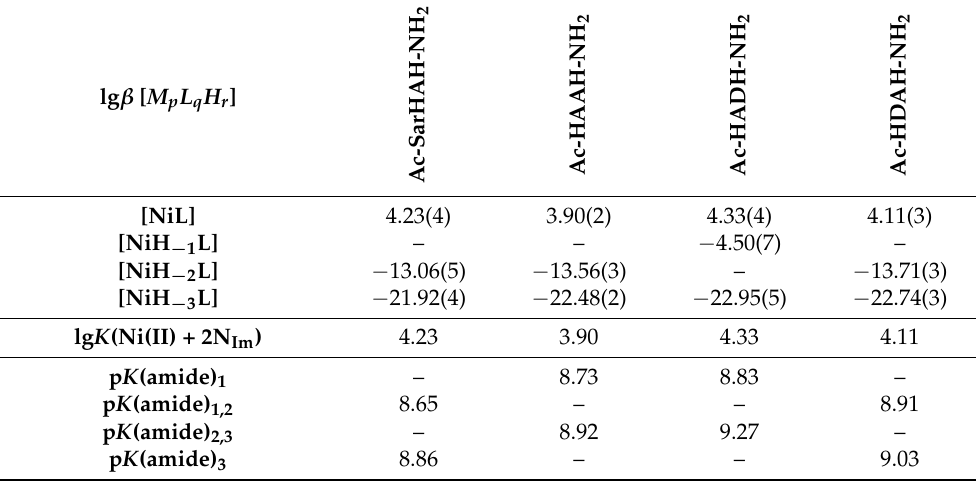
Table 5. Stability constants (log β ) and derived equilibrium constants of complexes formed in the different Ni(II)-multihistidine tetrapeptide systems (T = 298 K, I = 0.2 M